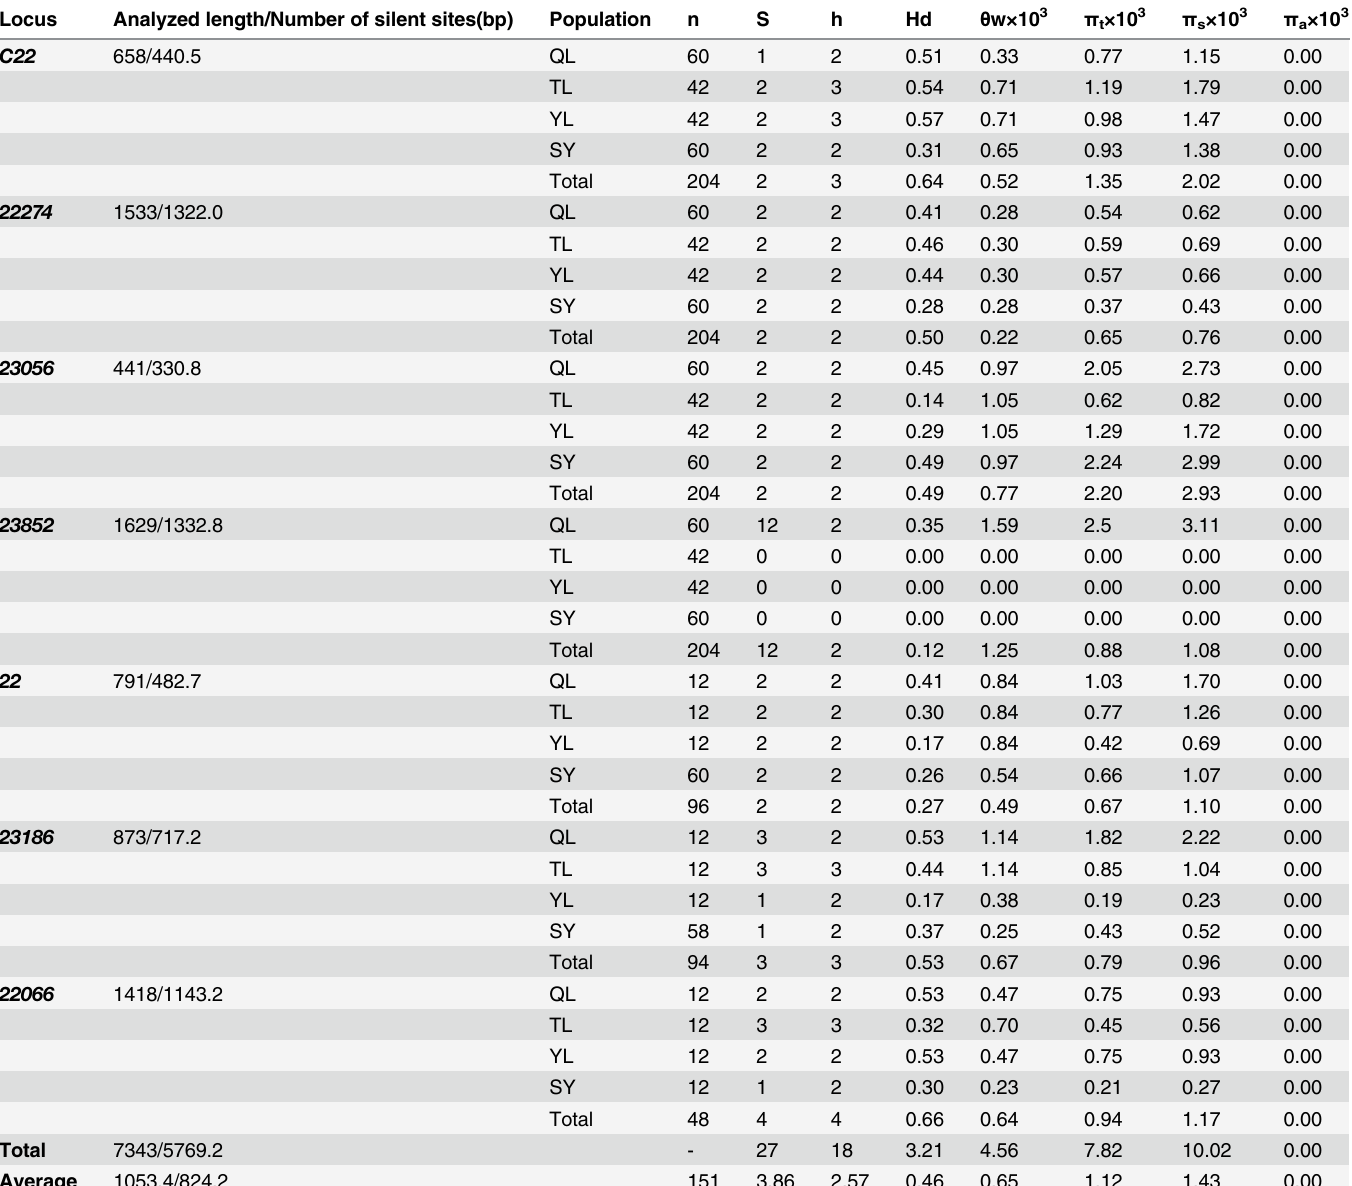
Table 2. Genetic diversity in the four R . apiculata populations in Hainan.